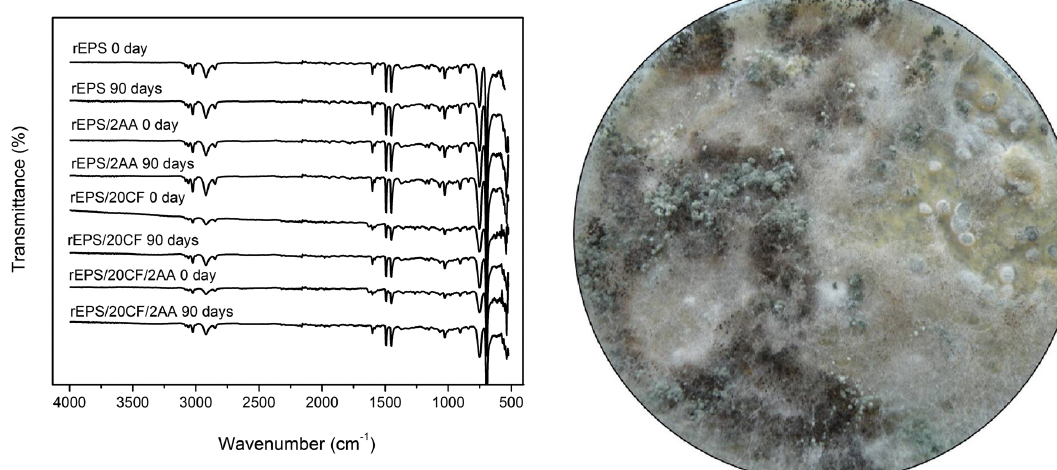
Figure 5. Spectra of the samples with and without the cotton fiber and the coupling agent before and after 90 days of exposure in the simulated soil.